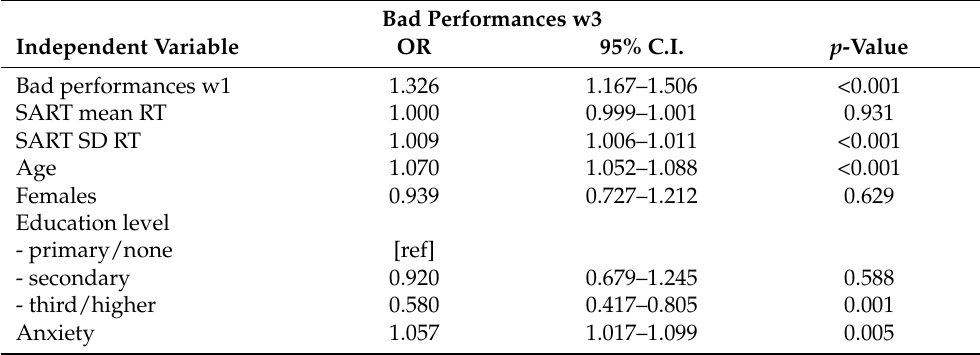
Table 4. Results for the fully adjusted per covariates binary logistic regression model 4 considering bad performances as potential predictor of having SART bad performances at wave